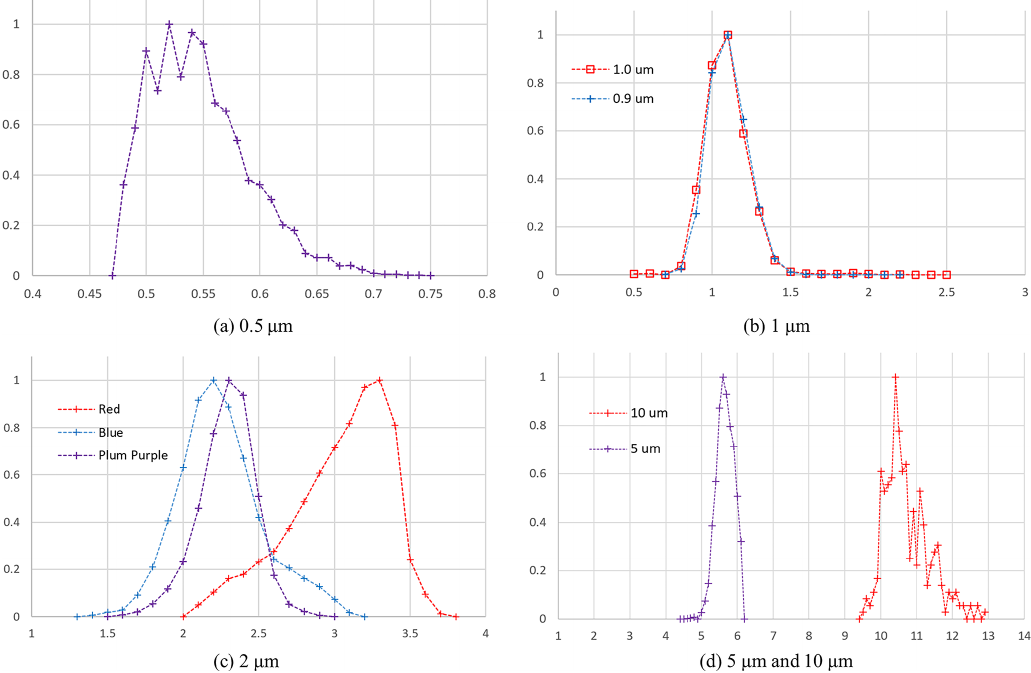
Figure 4. Size distribution estimated by the WIBS-NEO for different PSL particles with diameters ranging from